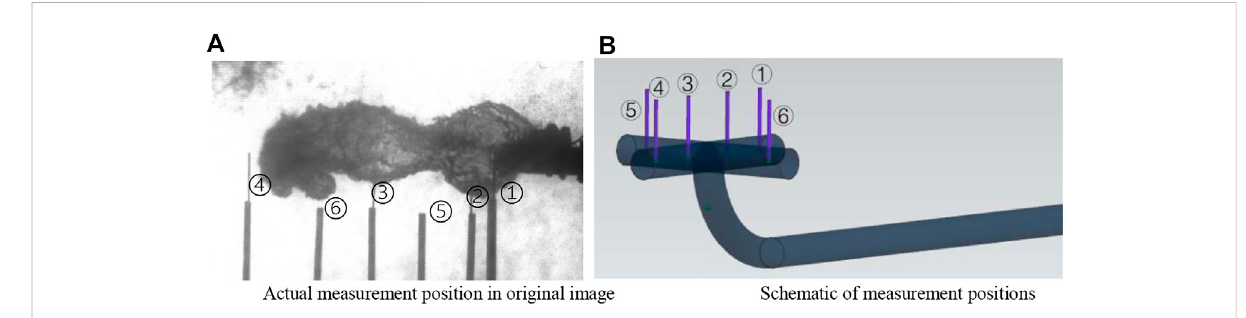
Schematicofmeasurementpositionsaroundandinsidethesteambubble. (A) Actualmeasurementpositionintheoriginalimage. (B) Schematic of measurement